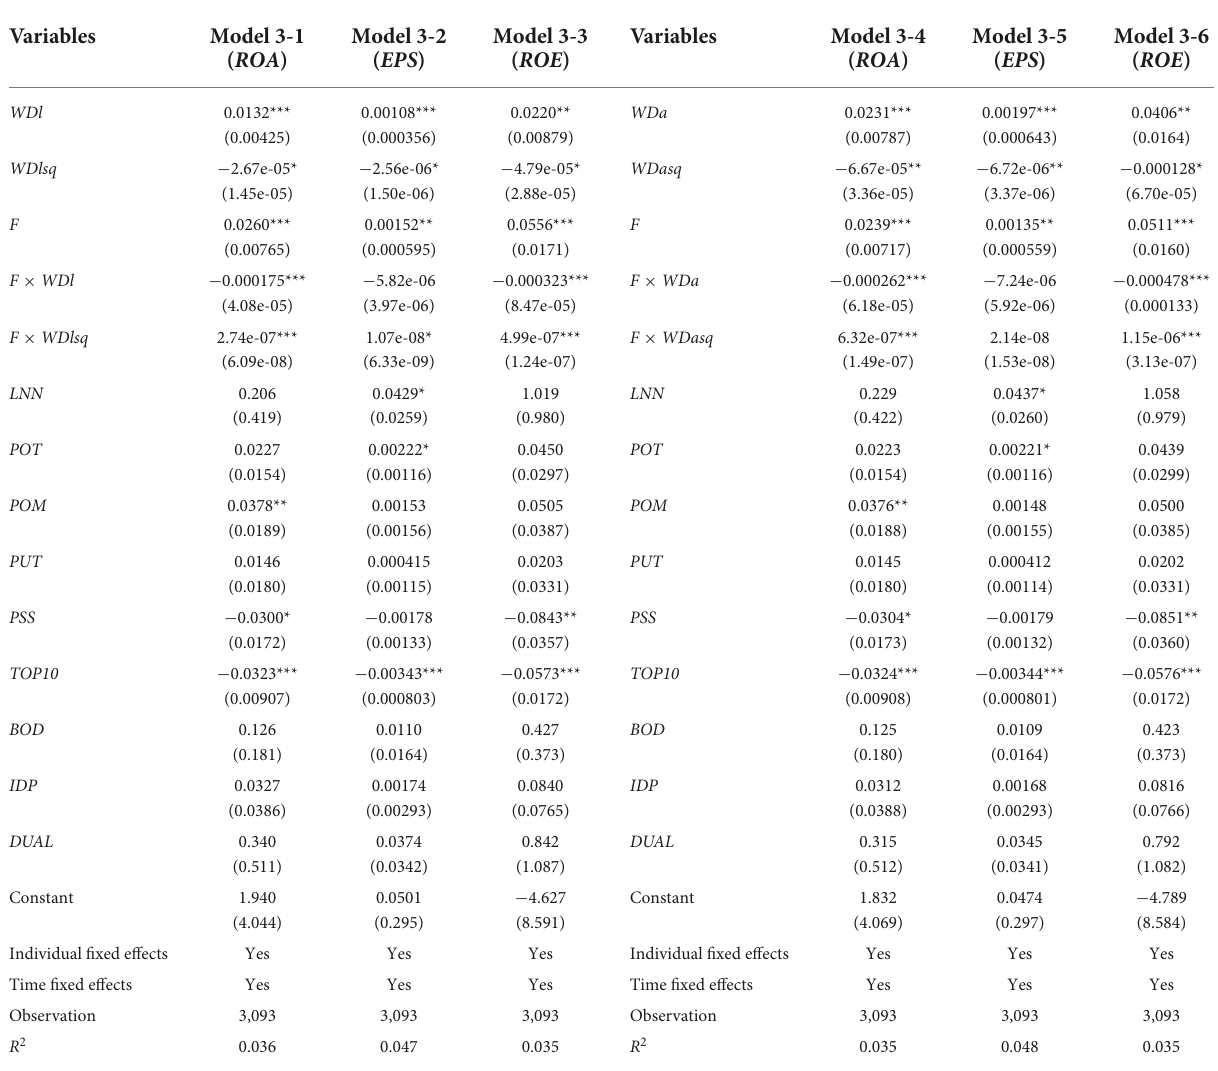
TABLE 5 Model 3 regression